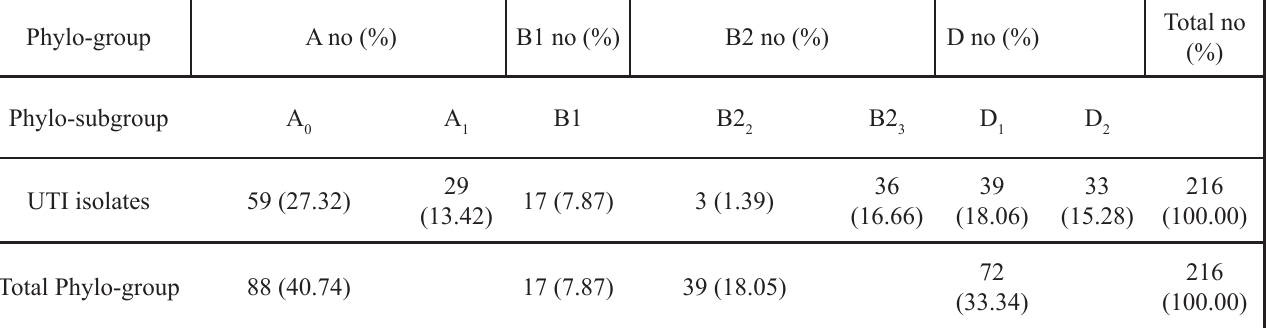
Table 2: Distribution of UTI E. coli isolates in detected phylo-group/subgroups Phylo-group